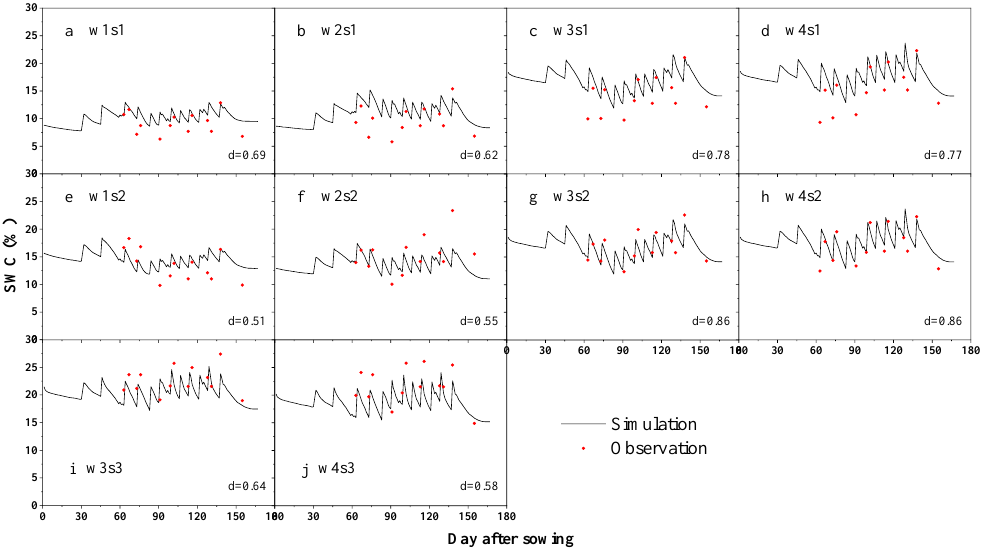
Figure 8. Comparison between observed and simulated average soil–water storage in the soil depth of 0–80 cm for different irrigation and salinity treatments ( a – j ). (The dots represent the measured data, the lines represent the simulated values. W1, W2, W3 and W4 represent irrigation amount of 22.5, 30, 37.5 and 45 mm. S1, S2 and S3 represent the soil salinity of 0.2%, 0.4% and 0.6%.)